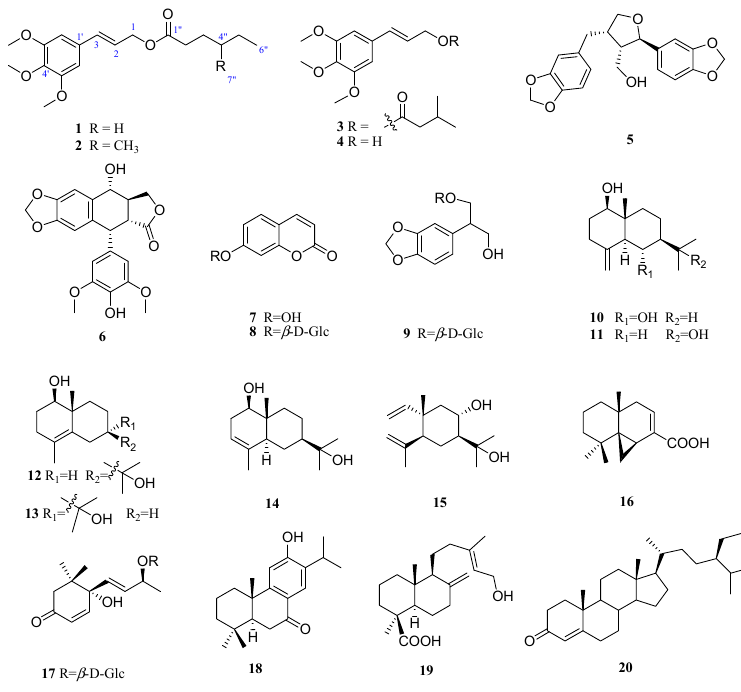
Figure 1. The chemical structures of compounds 1 – 20 .